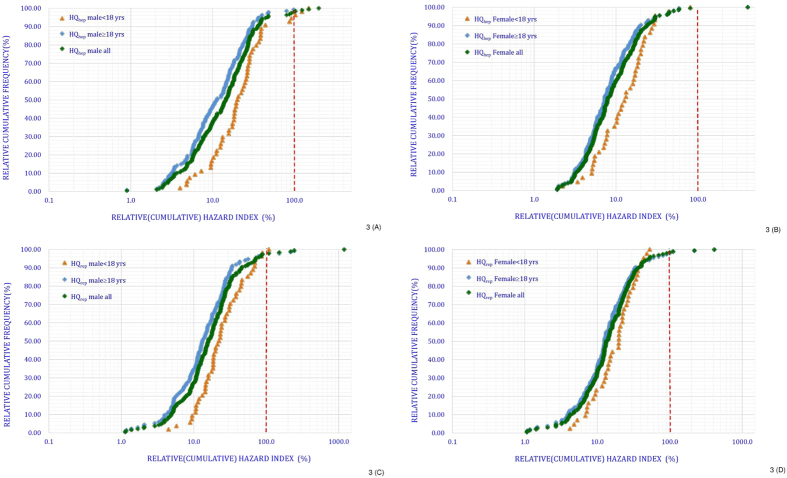
Cumulative risk of hepatic (A,B) and anti-androgenic effects (C,D) of phthalates in adults and minors: The dotted 100%-line illustrates the HI in respect to the cumulative HI (HIcum) for the different scenarios.